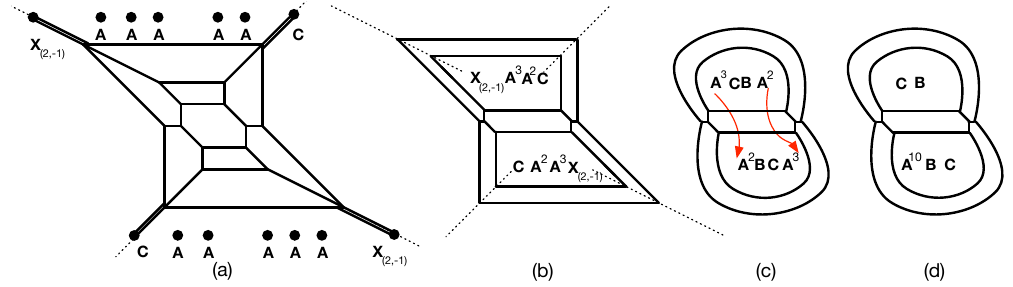
Figure 14 . (a) 7-brane con(cid:12)gurations for 5-brane web in (cid:12)gure 13, where A = (1 ; 0) 7-brane, C = (1 ; 1) 7-brane, and X = (2 ; (cid:0) 1) 7-brane. (b) 7-brane con(cid:12)guration where all the 7-branes (2 ; (cid:0) 1) are put in 5-brane loops. (c) Rearrangement of 7-branes. (d) 7-brane con(cid:12)gurations showing an A 10 BC = SO(20) symmetry, after allocating (cid:12)ve A ’s to the lower 5-brane loops.